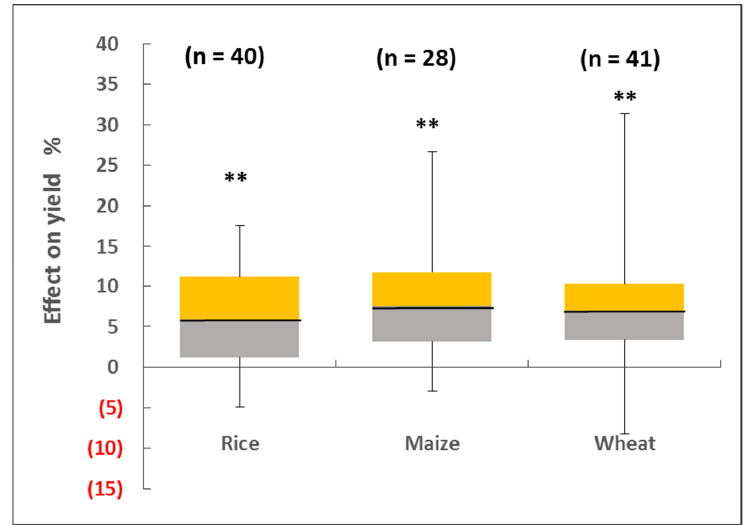
Figure 2. Box plot of the difference in the yield of one ‐ time application relative to split application in main grain crops collected from published literature. Analyses performed were one ‐ sample t ‐ test if normally distributed or one ‐ sample Wilcoxon signed rank test as data were non ‐ normal, and the ** showed significant differences ( p > 0.01) between the two nitrogen fertilizer application methods. Numbers of experimental observations are shown in parentheses. Thick line, median; boxes, interquartile; ranges (Q1–Q3); whiskers, non ‐ outlier range.